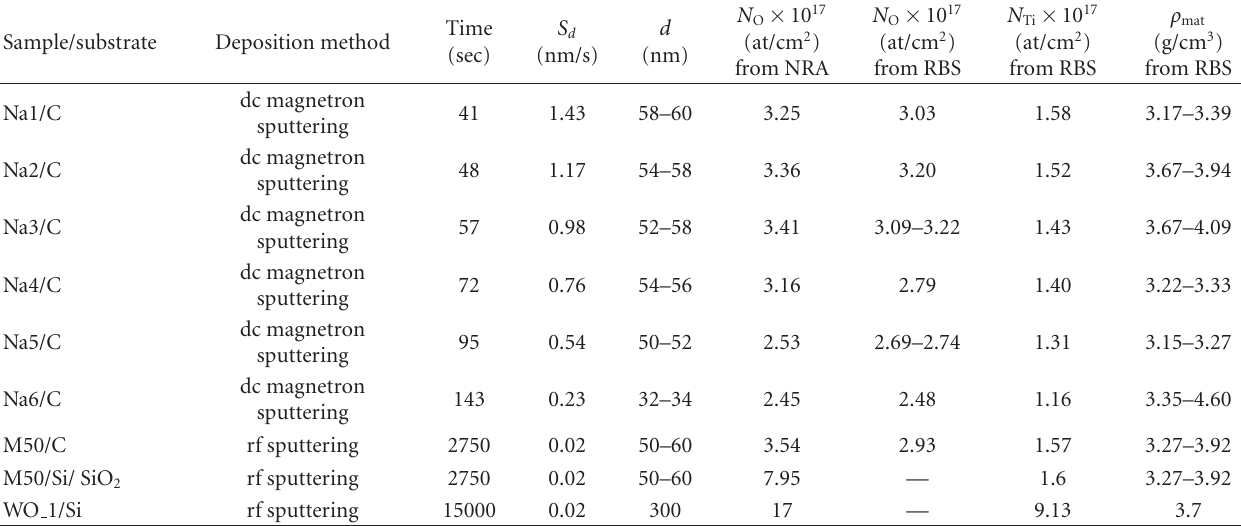
Table 2: Summary of the microanalysis of TiO 2 − y by RBS and NRA; S d : deposition rate, d : film thickness, N O : surface number of oxygen atoms, N Ti : surface number of titanium atoms, ρ mat : film density; calculated density of anatase ρ A = 3 . 864 g/cm 3 and calculated density of rutile ρ R = 4 . 250 g/cm 3 according to